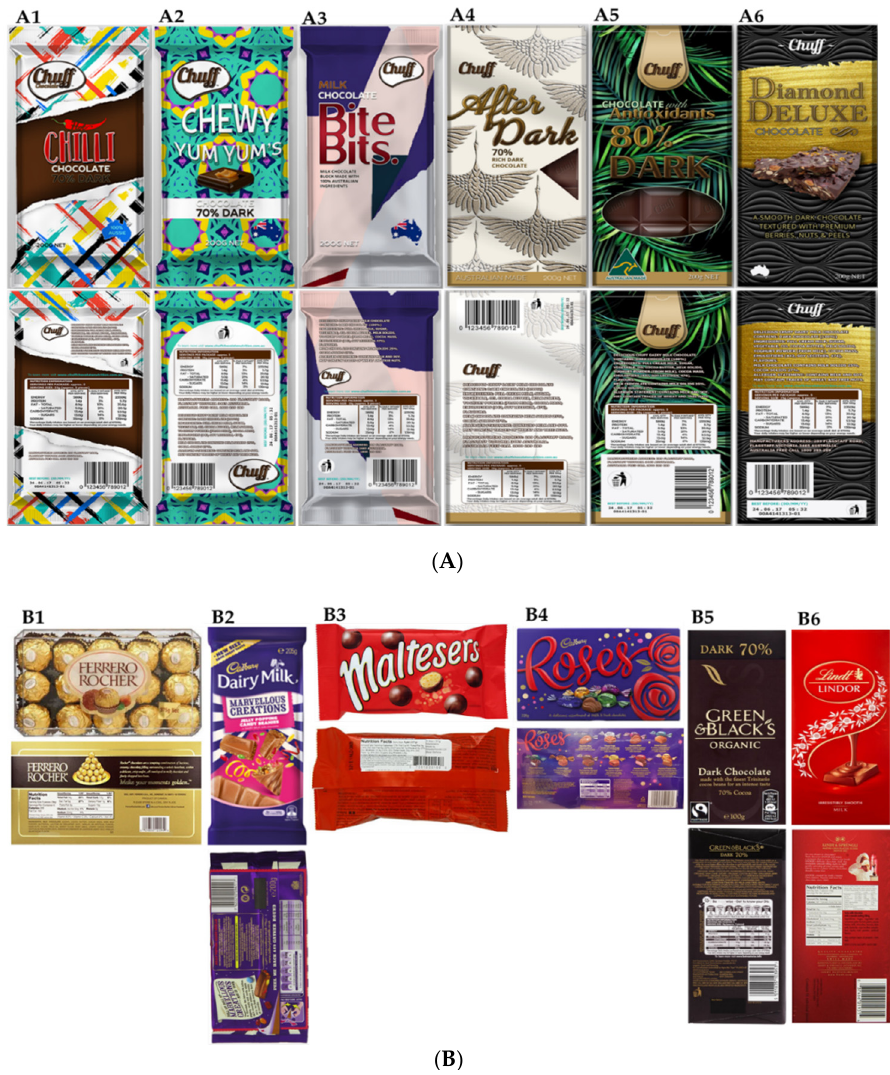
Figure 1. Front and back images of ( A ) novel and ( B ) familiar packaging concepts used for the study. ( A ) (A1) bold, (A2) fun, (A3) every day, (A4) special, (A5) healthy, and (A6) premium. ( B ) (B1) Ferrero Rocher, (B2) Cadbury Marvellous Creations, (B3) Maltesers, (B4) Roses, (B5) Green & Black’s, and (B6)